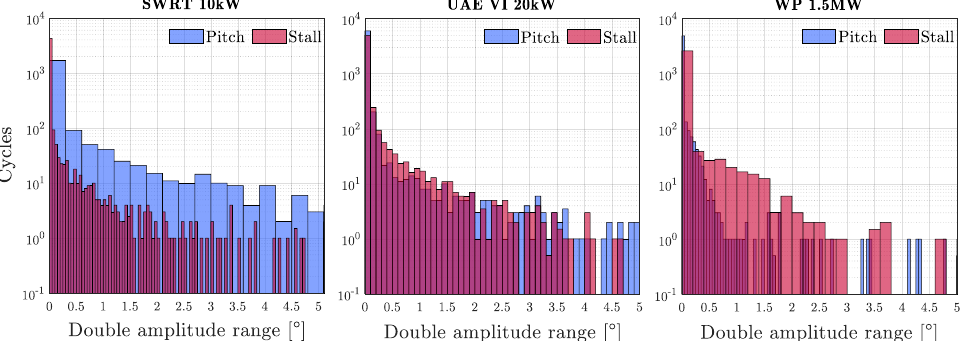
Figure 12. Number of cycles pitch-to-feather and pitch-to-stall in comparison for small oscillation amplitude